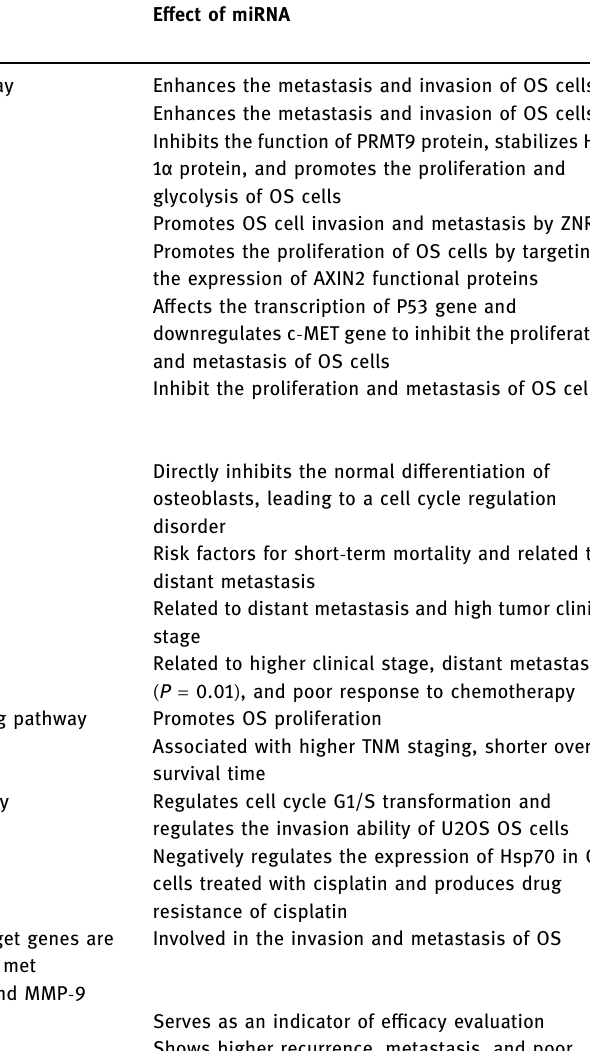
Table 2: Summary of important miRNA type associated with OS miRNA